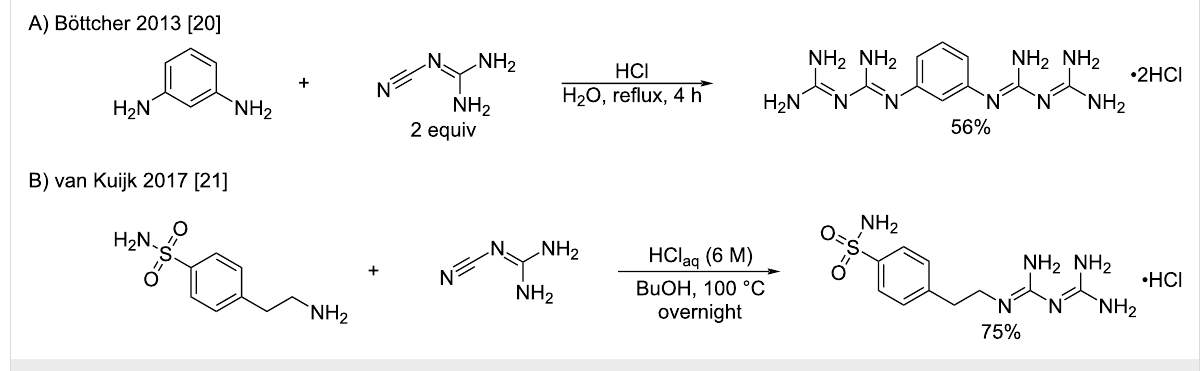
Scheme 6: Synthesis of aryl- and alkylbiguanides by adaptations of Cohn’s procedure [20,21].